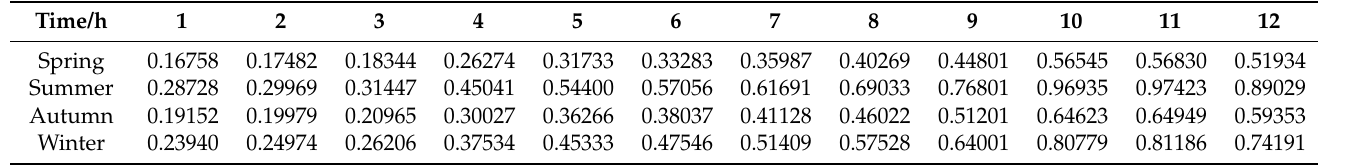
Table A4. Wind speed data of four seasons